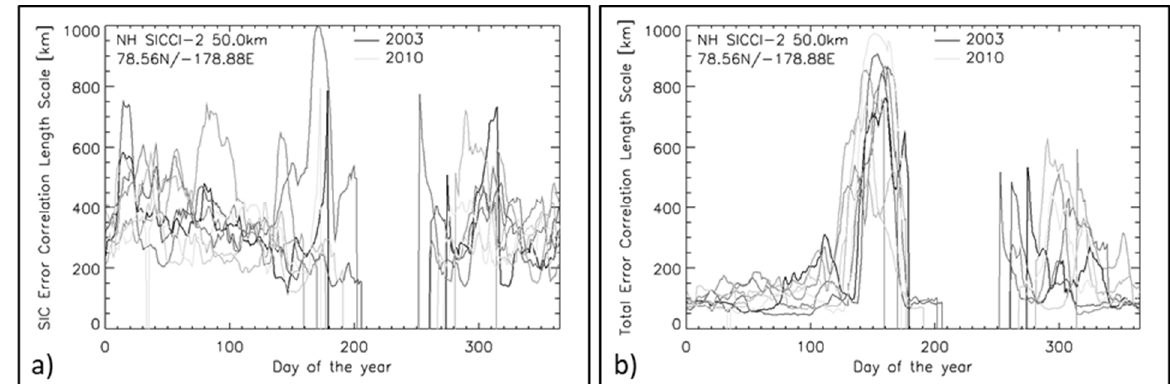
Figure 11. Time series of the average SIC error correlation length scale ( a ) and average total error correlation length scale ( b ) for the same area north of Wrangell Island used in Figure 10 for SICCI-50km for years 2003 to 2010. The time series of each year is shown at a different gray tone with the most recent year (2010) shown in light gray. Zero values denote data gaps due to either missing data files (two days between day of the year 30 and 40 in 2010) or due to SIC values dropping below 90% (during summer).